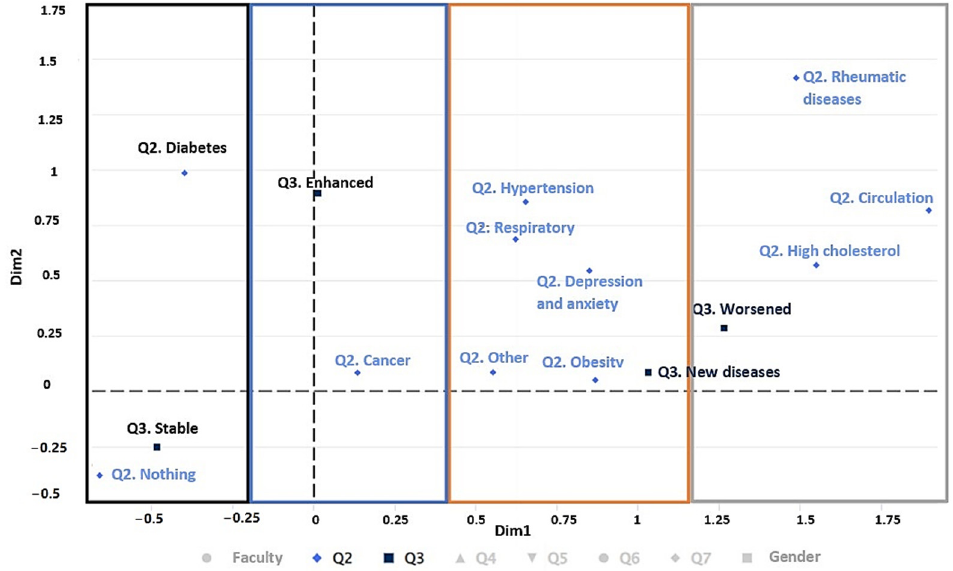
Figure 7. Multiple correspondence analysis (MCA) of the variables of faculty, Q2, and Q3.